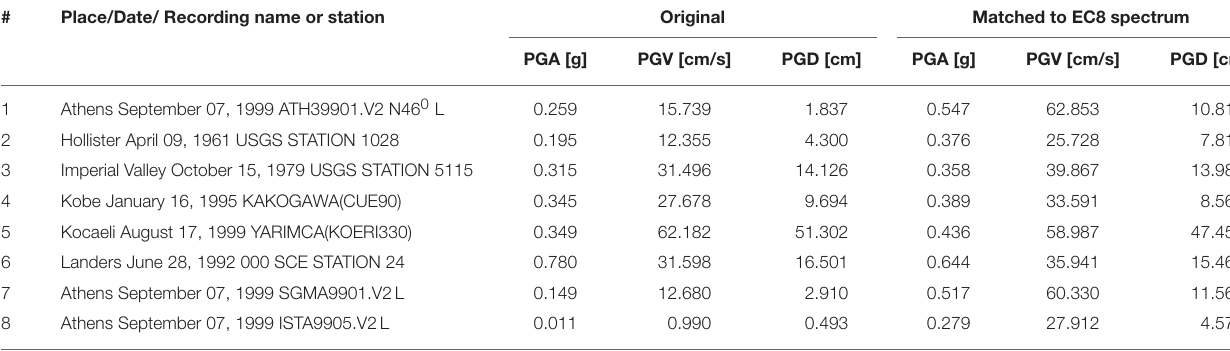
TABLE 6 | Extended accelerogram set.